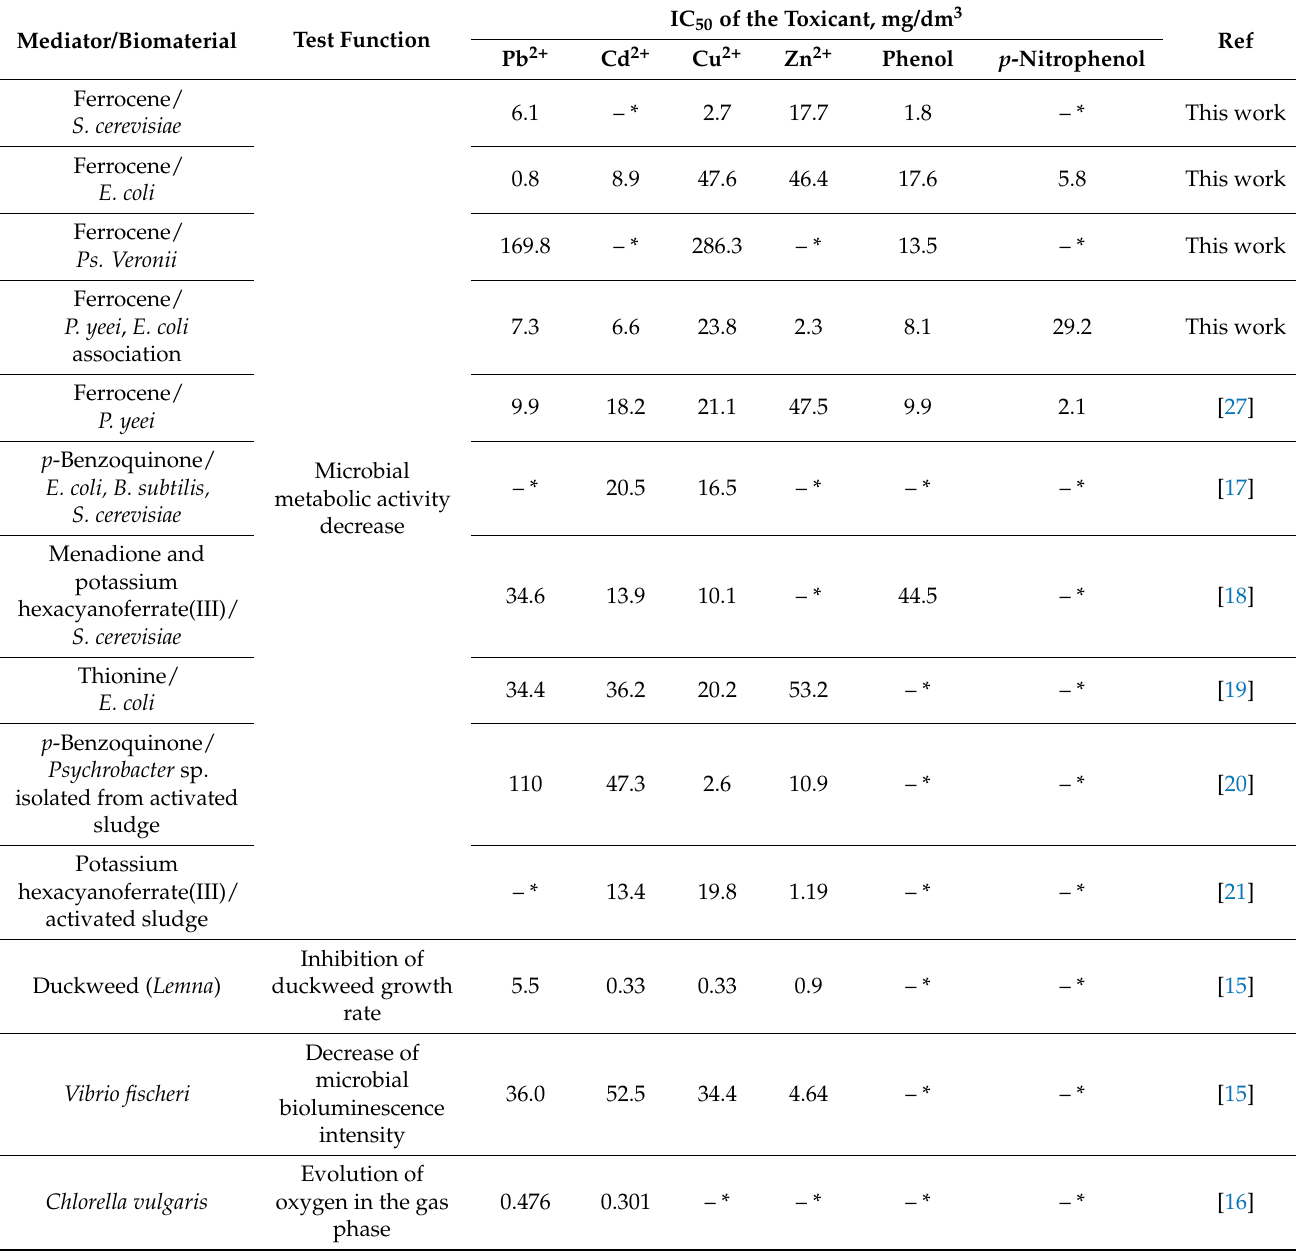
Table 2. Inhibitor solution concentration inducing a decrease of the receptor element activity by